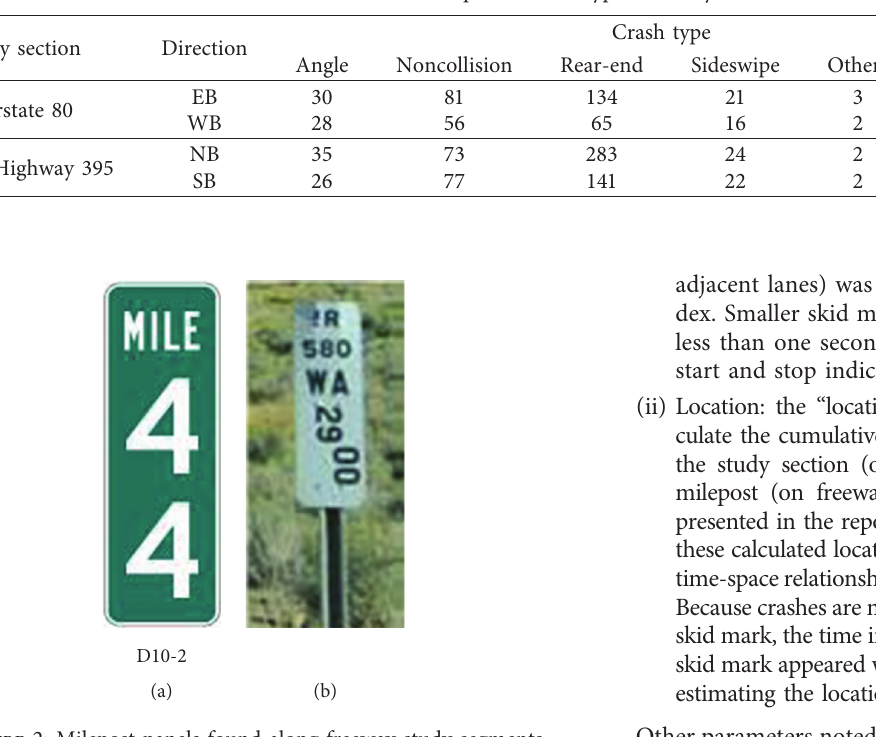
Figure 1: Map of freeway study sections. Table 1: Reported crash types in study sections.